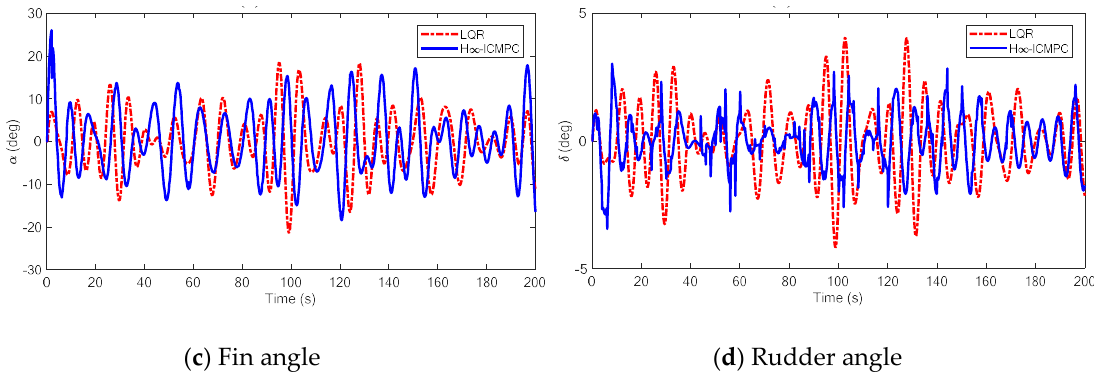
Figure 5. Simulation curves of the ship roll-yaw motions using LQR/ H ∞ -SFMPC control law. Table 3. Statistical simulation results of the ship roll/yaw motions using different control law at the encounter angle of 90°.